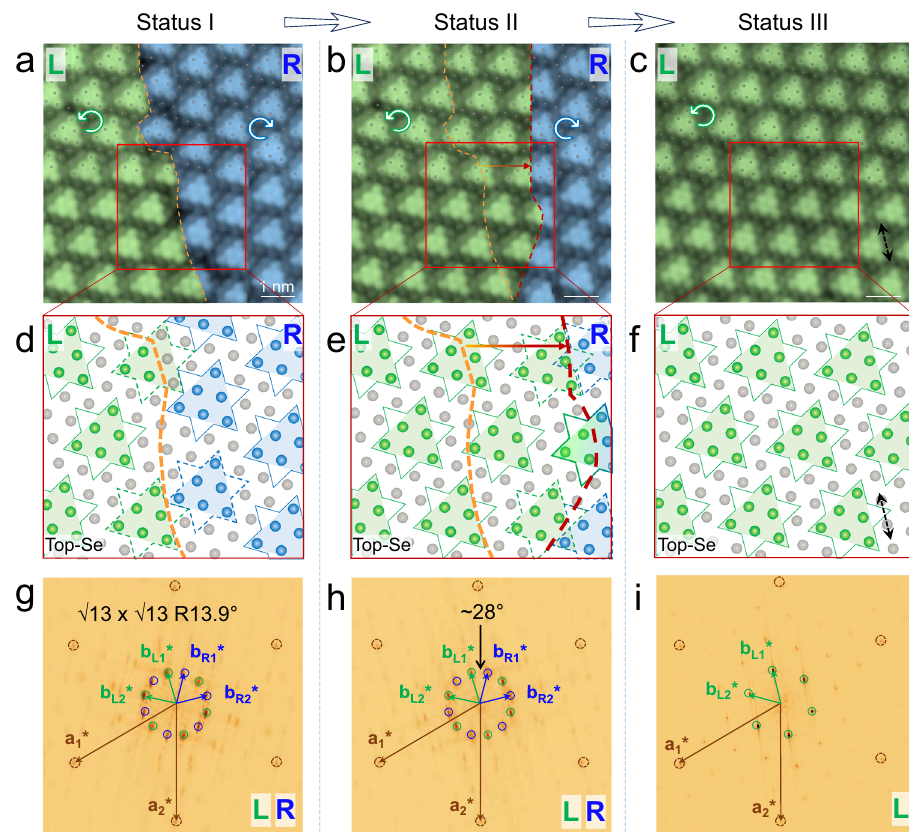
Fig. 2 Continuous atomic arrangement during the chirality switching of the CDW superlattice. a – c Atomic-resolution images of the same area of the 1T- NbSe 2 island before ( a ) and after ( b ) boundary movement of chiral domains, demonstrating a chiral change from a coexistence of the L-R domain to a pure L domain ( c ). The upper part of each image is overlaid by a well-ordered lattice of gray balls, indicating that the top-layer Se lattice is continuous over the whole area from L to R domains. d – f Atomic model of SL 1T-NbSe 2 with the shifted CDW domain boundary, describing the same area marked by the red frame in ( a – c ). The green and blue balls represent Se atoms in the SOD with left and right chiralities, respectively, while the gray balls show the Se atoms surrounding the SOD. All Se atoms (in blue, green, and gray) share the same periodic hexagonal lattice. g – i FFT images of ( a – c ) showing that both statuses I and II have two chiral sets of spots. In status III, there is a reduction to one set of spots for the CDW superlattice. The unit vectors of a 1 * and a 2 * in reciprocal space originated from the top-Se lattice, b L1 * and b L2 * from the L domain, and b R1 * and b R2 * from the R domain, respectively. Scanning parameters: a , − 1.5 V, 1 nA. b and c , − 1.5 V, 2